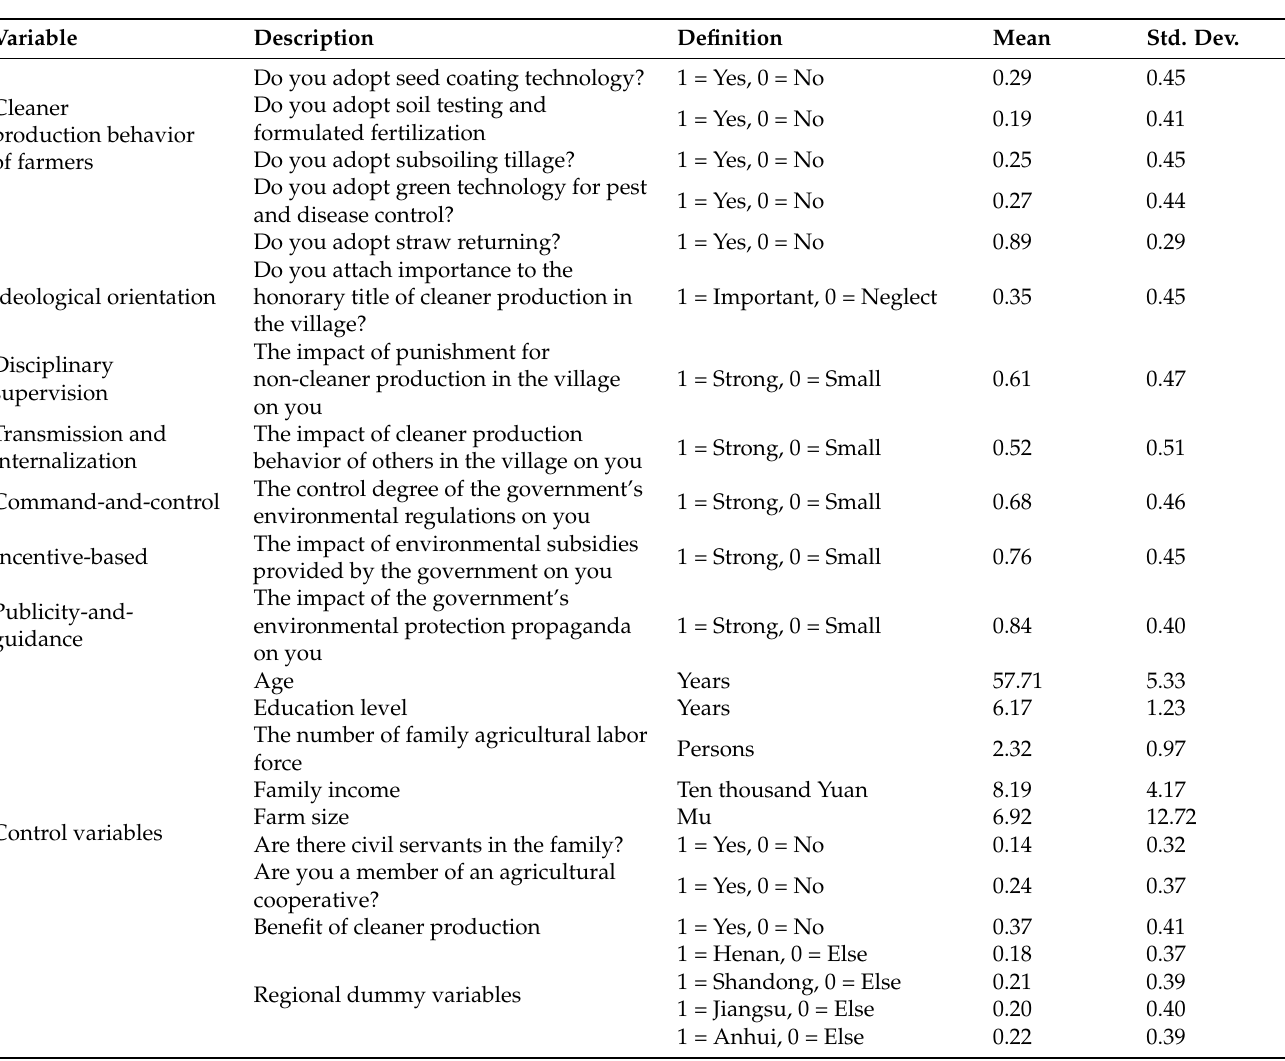
Table 1. Descriptive statistics of